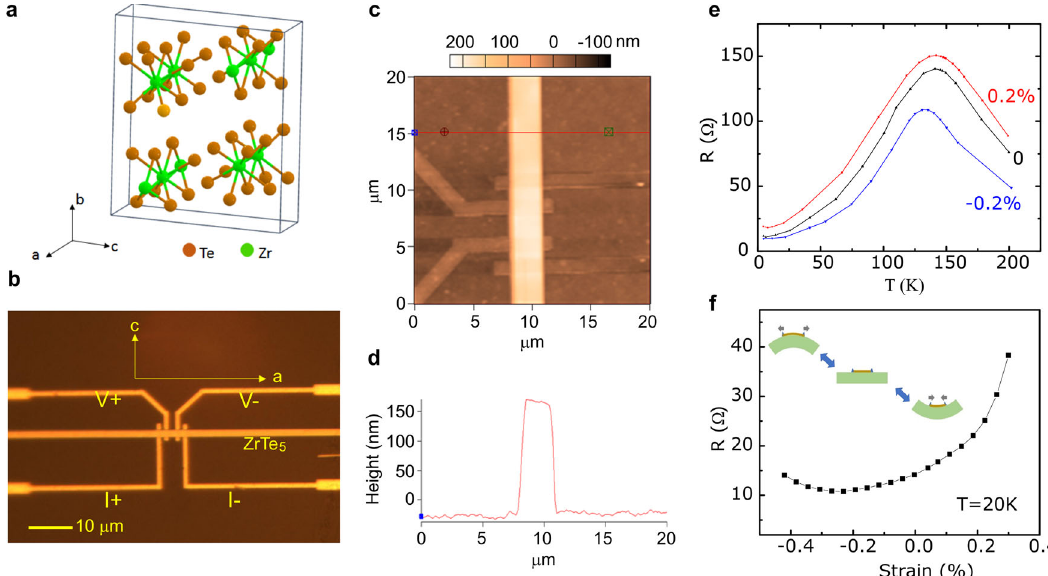
Fig. 1 ZrTe 5 under strain. a Crystal structure of ZrTe 5 . b Optical microscope image of ZrTe 5 microcrystal on Polyimide substrate with prede fi ned current and voltage electrodes. c Atomic force microscope image of the sample. d The cross section of the ZrTe 5 crystal, with a thickness of ~190 nm. e Resistance versus temperature dependence under various external strains. f Non-monotonic strain dependence of resistance at the fi xed temperature of 20K, showing a resistance minimum at compressive strain ≈ − 0.2%. Inset: application of uniaxial strain through substrate